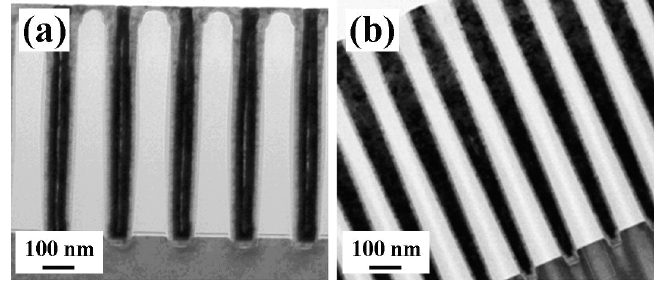
Figure 7. TEM images of fill-in performance on special funnel-like profile. ( a ) MOCVD TiN; ( b ) High aspect ratio of 12:1 deep contact with SFD TiN barrier.